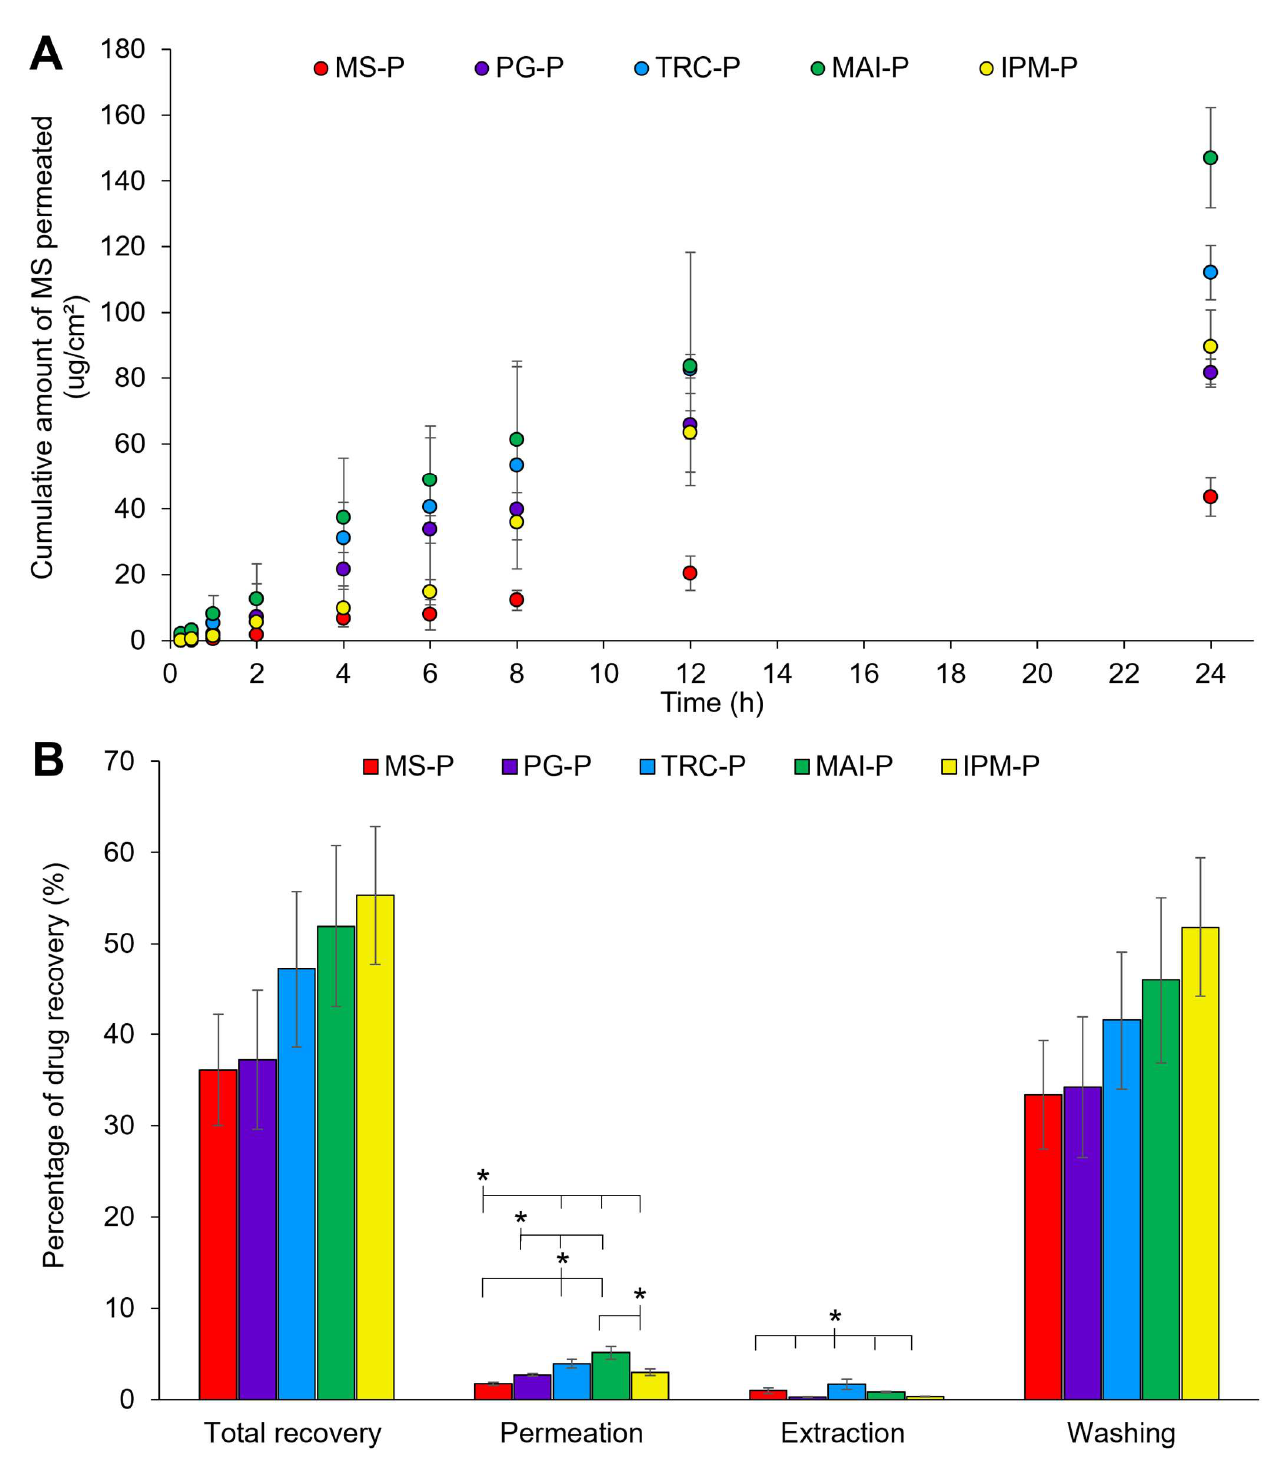
Figure 6. ( A ) In vitro permeation and ( B ) mass balance studies of MS-loaded patches with different solvents (n = 3, mean ± SD; * p < 0.05, ANOVA). PG: propylene glycol; TRC: Transcutol ® P; MAI: Maisine ® CC; IPM: isopropyl myristate) over 24 h using porcine ear skin. MS: methyl salicylate; MS-P: patches with drug but without solvent; -P: patches with drug and solvent.